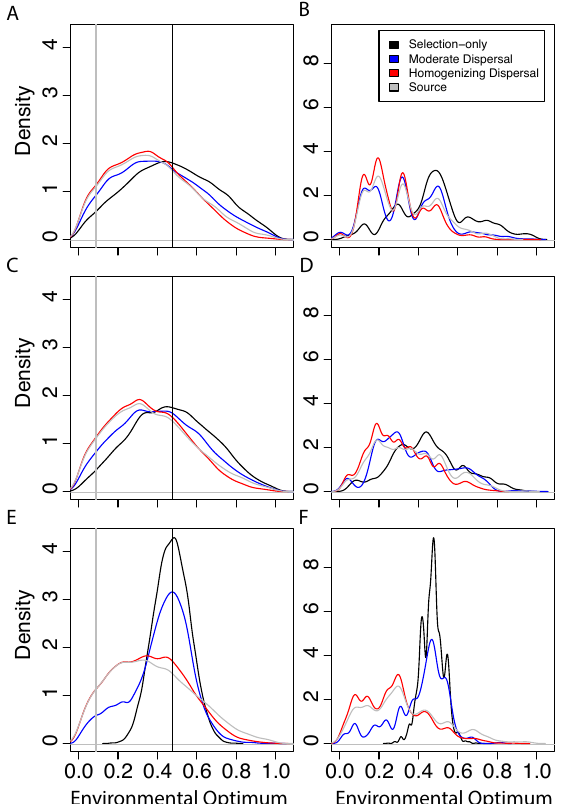
Figure 3. Kernel density of species optima are shown under wide (( A , B ), niche breadth = 0.175), moderate (( C , D ), niche breadth = 0.086842105), and narrow (( E , F ), niche breadth = 0.0075) niches in the mid-point environment (0.476315789, vertical black line). Column 1 displays distributions of species optima without accounting for abundances. Column 2 displays distributions of individuals’ optima. Distributions for the source community and its environment condition (vertical line) are displayed in gray. The same communities were selected as examples to generate Figures 2 and 3.